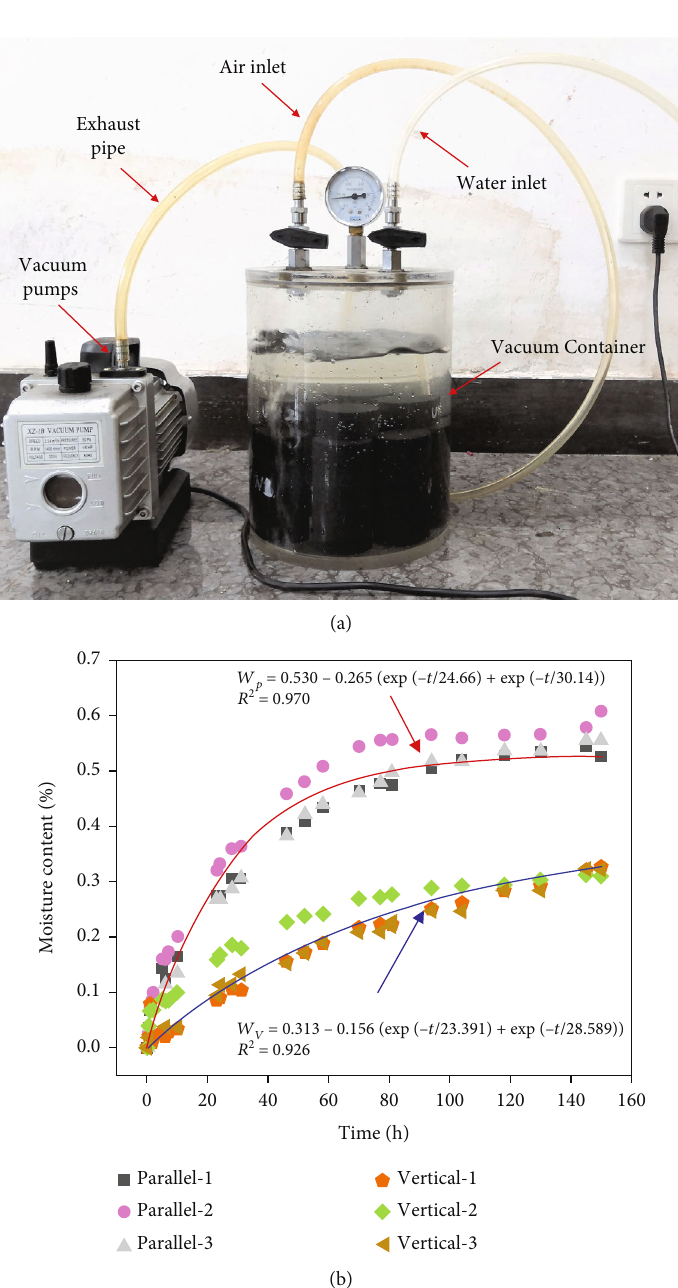
Figure 3: (a) Vacuum-saturated device. (b) Moisture content-time curve of shale